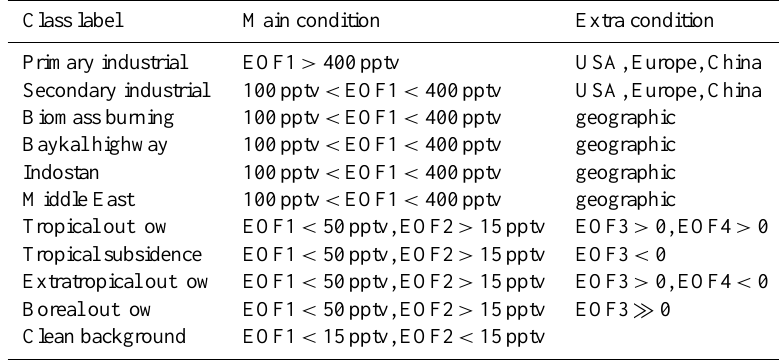
Table 2. Model-based source and outflow class definitions based on EOF decomposition. Class